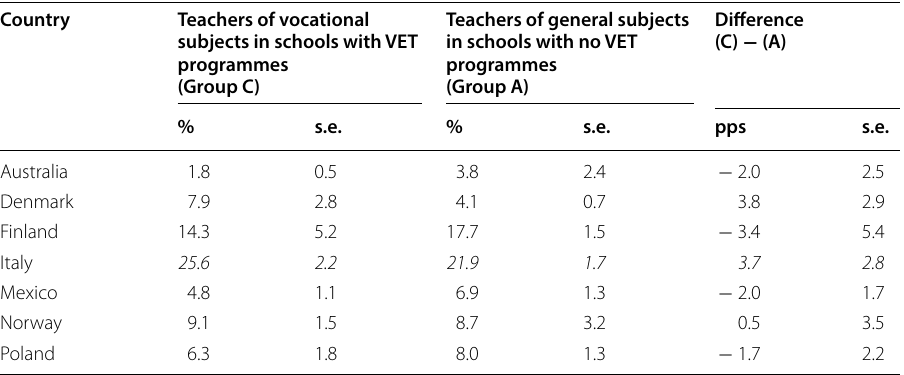
NB: Data refer to teachers in upper secondary education. Positive values of the difference indicate that in a given country non participation is higher for teachers of vocational subjects than for teachers of general subjects. The (*) indicates that